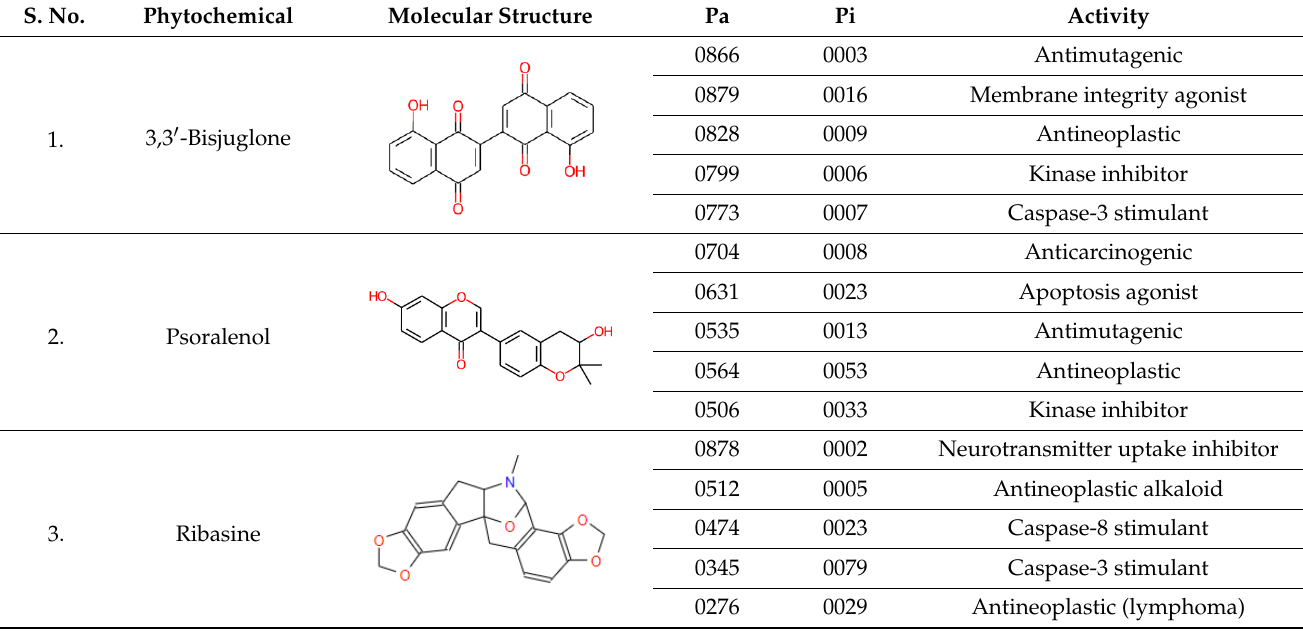
Table 3. PASS analysis and molecular structures of the selected compounds.